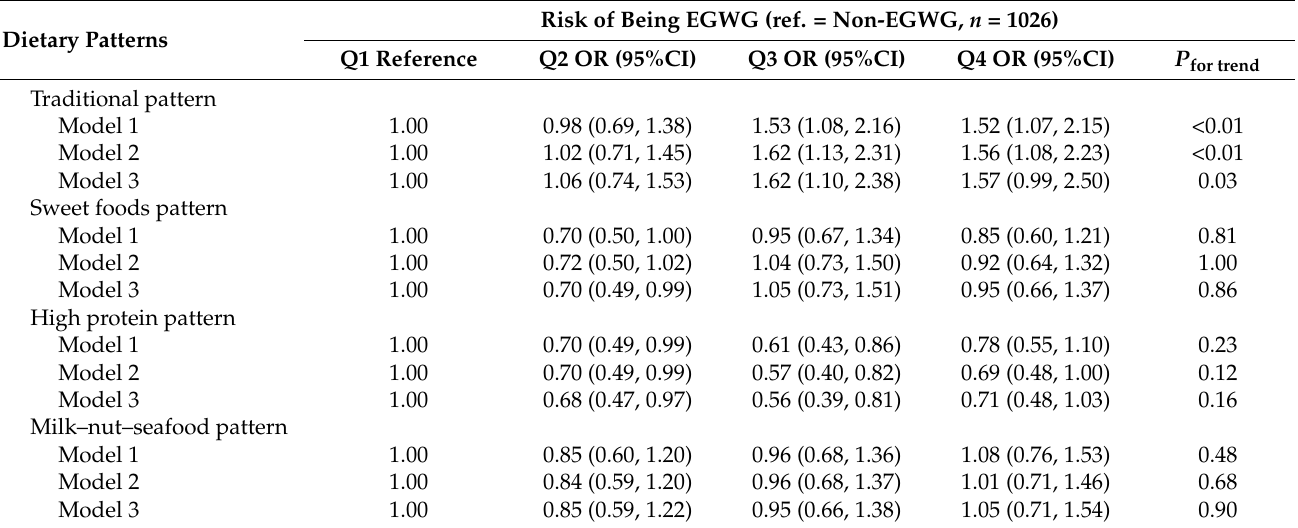
Table 4. Crude and adjusted odds ratios for being EGWG by the quartiles of dietary pattern scores.